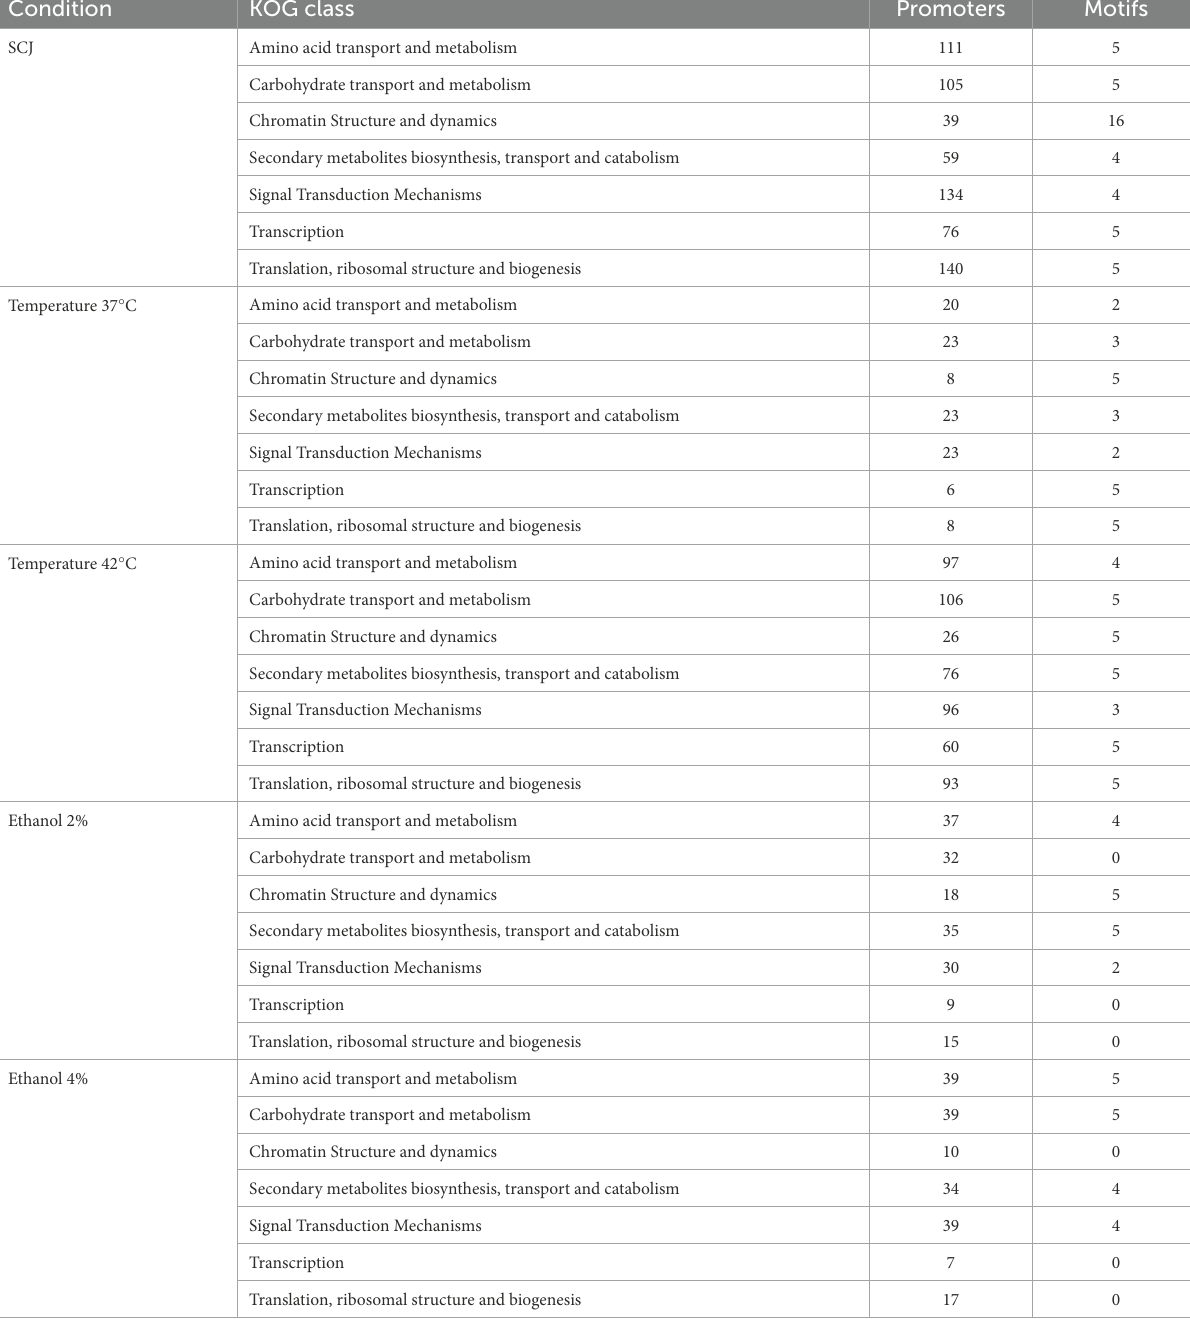
TABLE 1 Mining of promoter and transcription factor binding sites (TFBS) sequences. Condition KOG